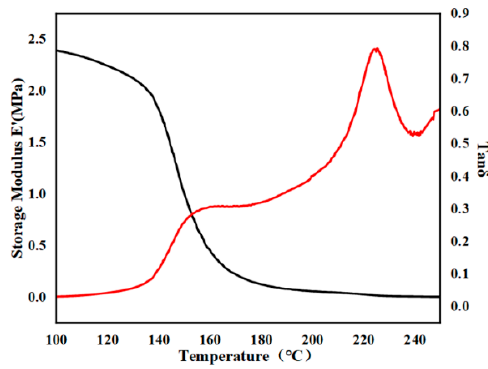
Figure 6. DMA curves of PEI3a.